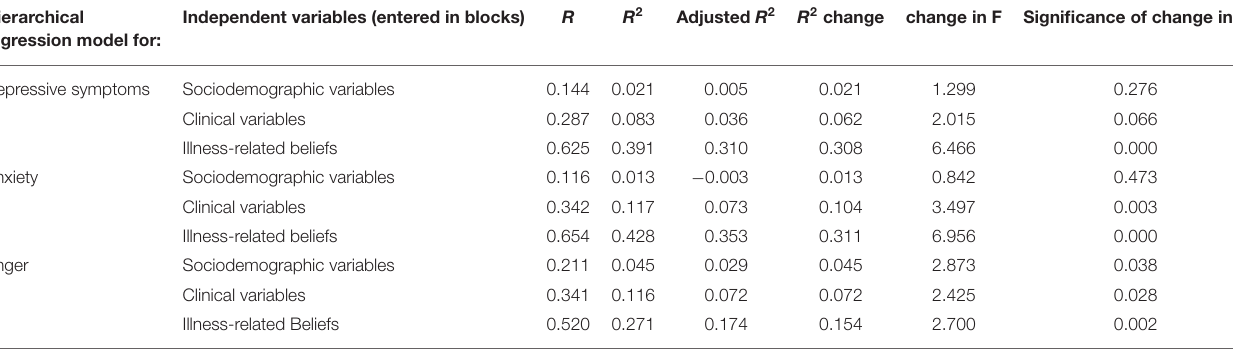
TABLE 4 | The role of sociodemographic and clinical variables and illness-related beliefs in explaining the variance of ED symptoms—hierarchical regression analysis. Hierarchical Independent variables (entered in blocks) regression model for: